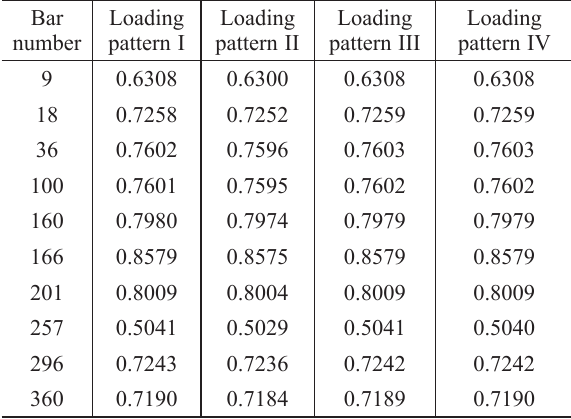
Table 9. Results under different loading